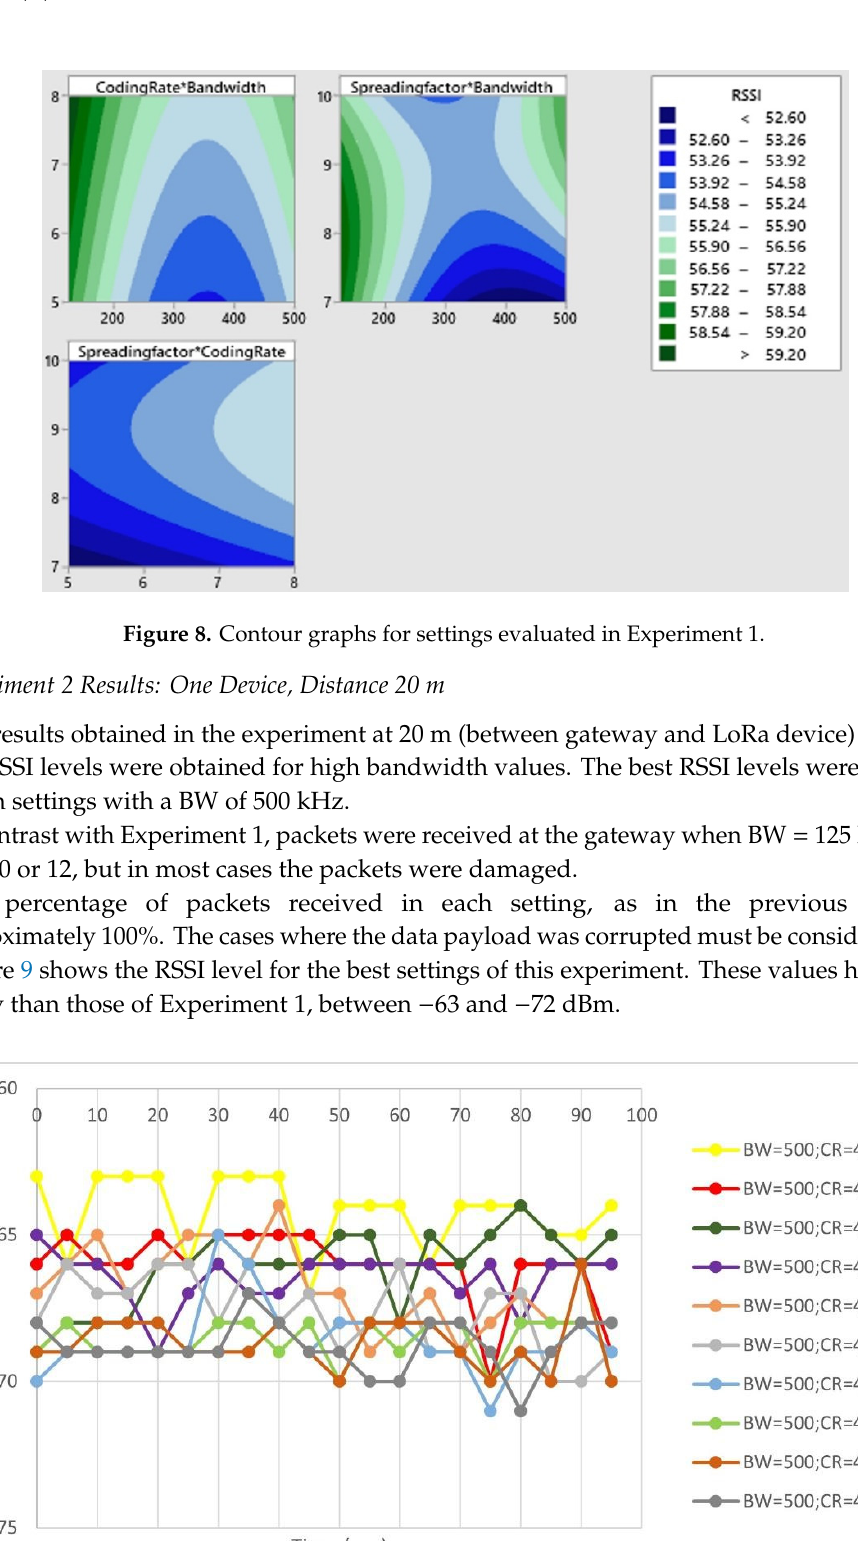
Figure 7. Receive signal strength indicator (RSSI) values for the best 10 settings in Experiment 1.